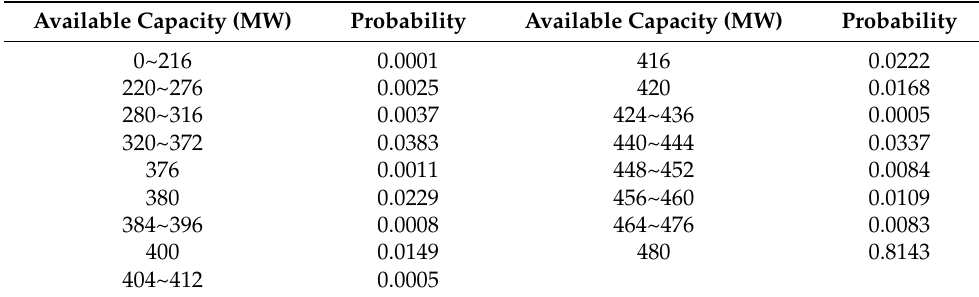
Table 2. The probability density of available capacity.